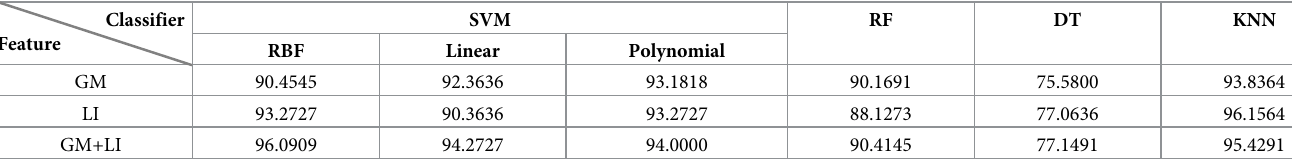
Table 2. Classification results in NC versus LMCI under three kinds of features(%).